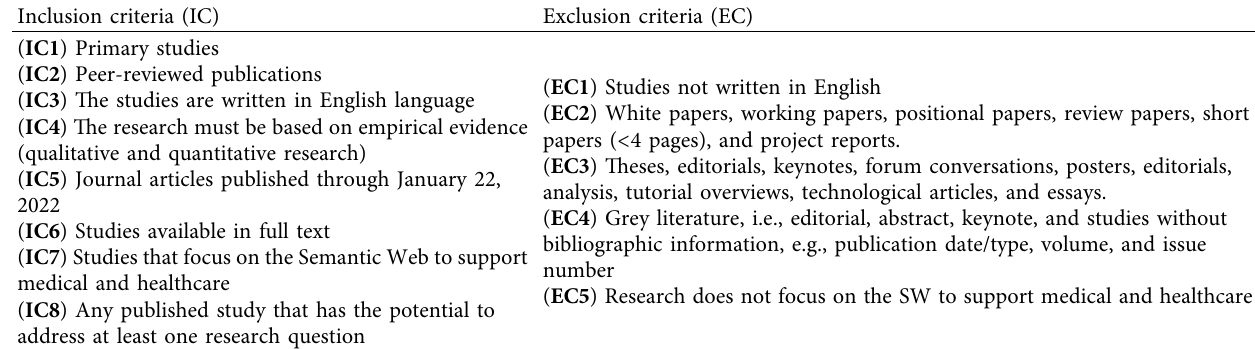
Table 1: Criteria for inclusion and